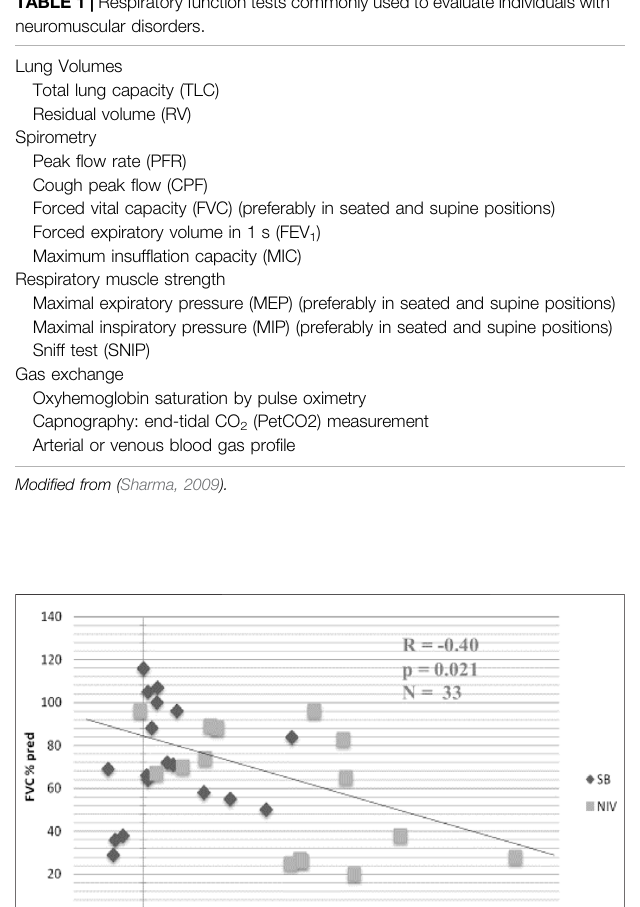
Frontiers in Physiology |